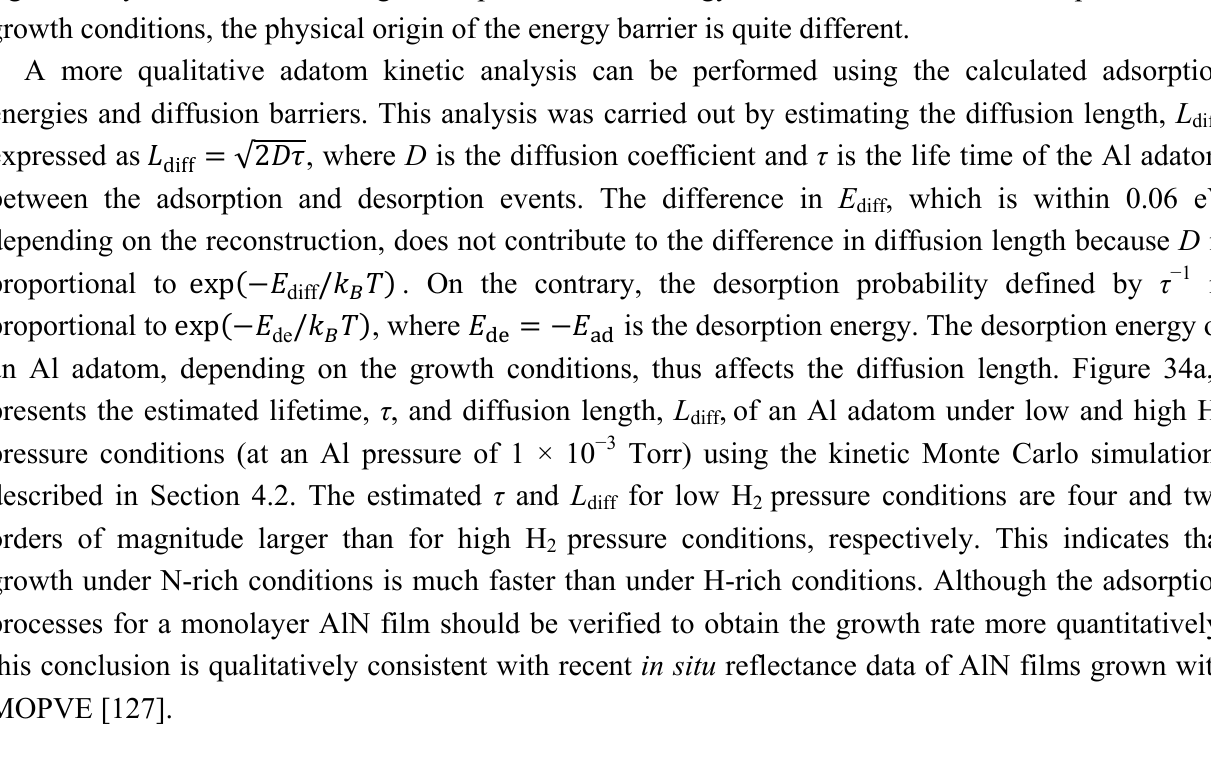
, of an Al adatom on a diff